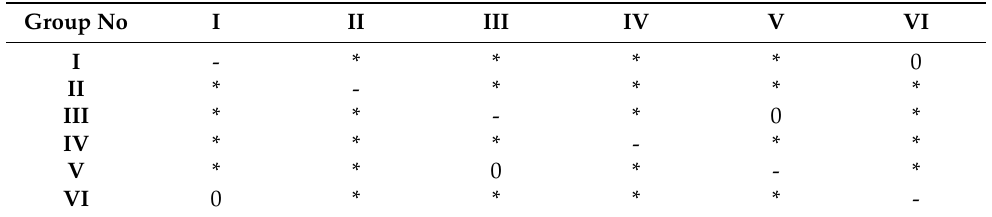
Table A6. The capsule’s surface area and capillary tuft in kidneys of animals fed with regular diet. Statistical differences between all experimental groups; * significant, 0 insignificant.